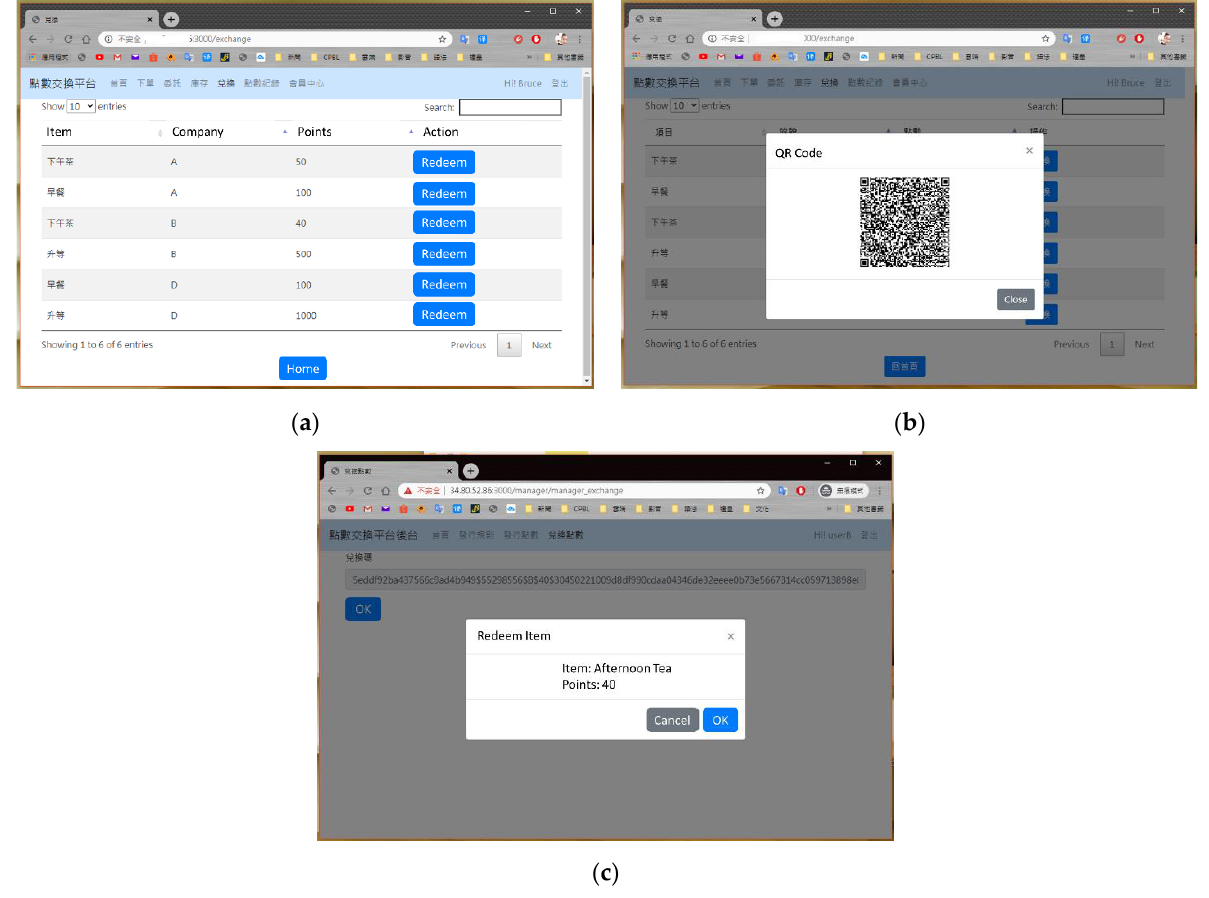
Figure 5. User interface of issuance.